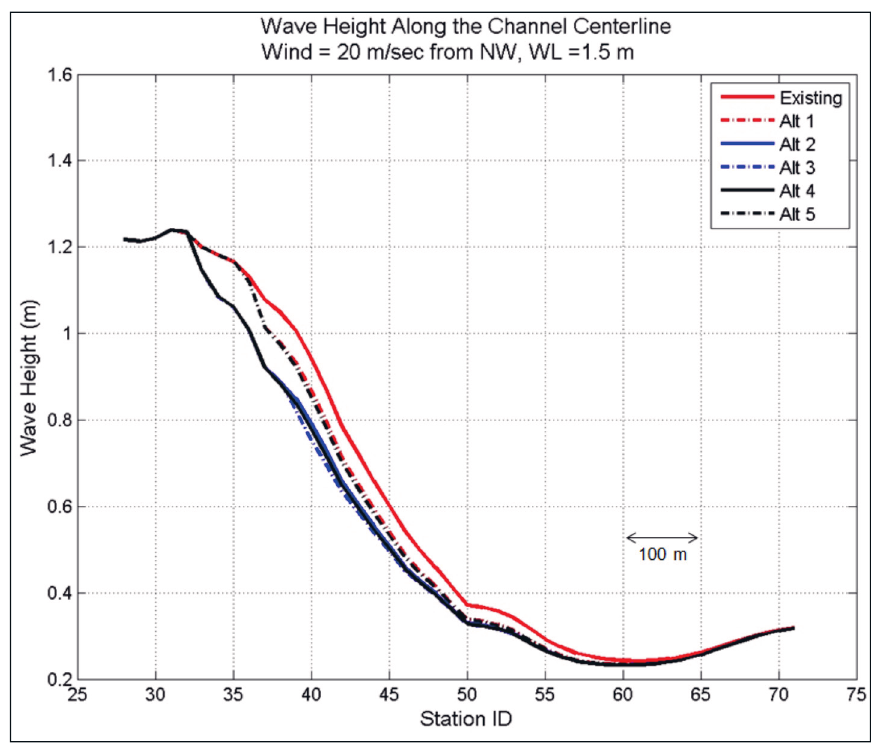
Figure 20. Model wave heights in the west channel for 50-year design wind from NW and WL = 1.5